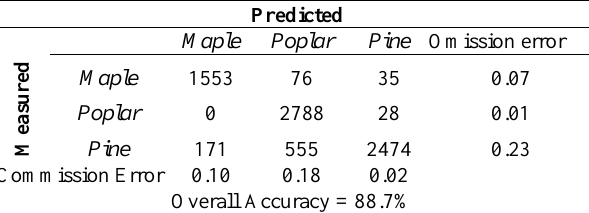
Table 2. Confusion matrix for genera classification for